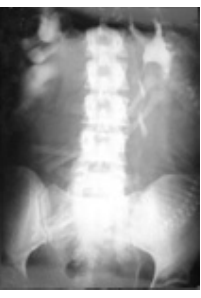
FIGURE 1 . Excretory phase of intravenous "one shot" pyelography demonstrating appearance of obstructed renal pelvis. Note intrauterine fetal bony elements representing third trimester pregnancy.